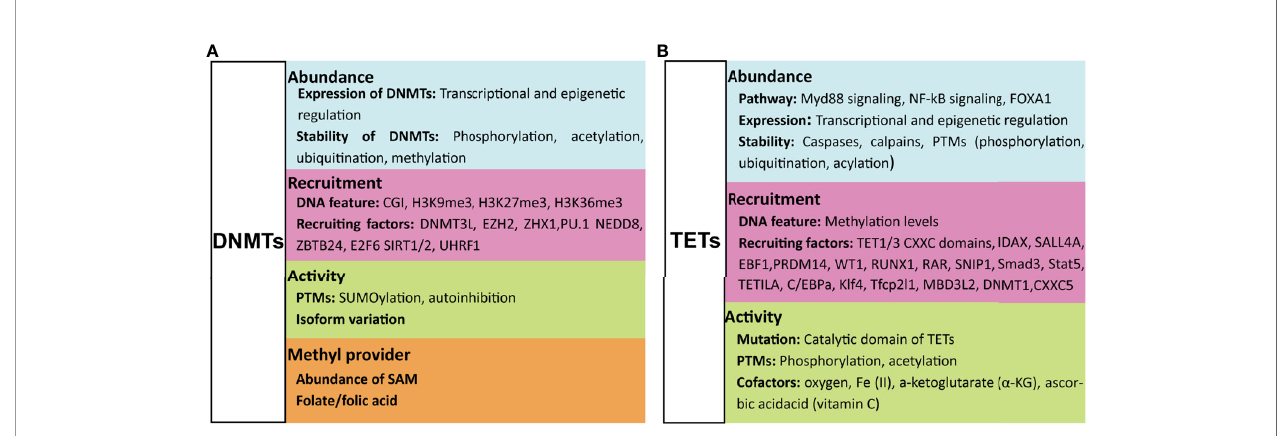
FIGURE 2 | Factors that regulate the function of DNMTs and TETs. The function of DNMTs can be in fl uenced at four levels: their abundance, their recruitment to DNA, their catalytic activity, and the methyl group source (A) . The function of TETs is regulated at three levels: their abundance, their recruitment to DNA and their catalytic activity (B) . For details see text. DNMTs, DNA methyltransferases; TETs, ten-eleven translocation methylcytosine dioxygenases; PTMs, post-translational modi fi cations; CGI, CpG islands; SAM,